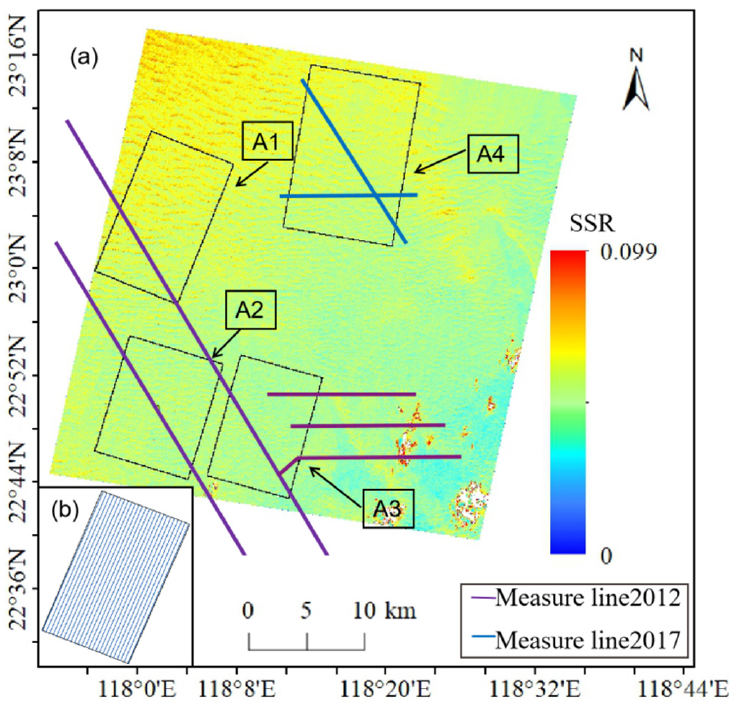
Figure 2. ( a ) Experimental area of A1, A2, A3, and A4. The purple line is the measured water depth in 2012, and the blue line is the measured water depth in 2017. The legend indicates the value of the SSR. ( b ) Distribution of 25 measurement lines with 500 m interval in A1